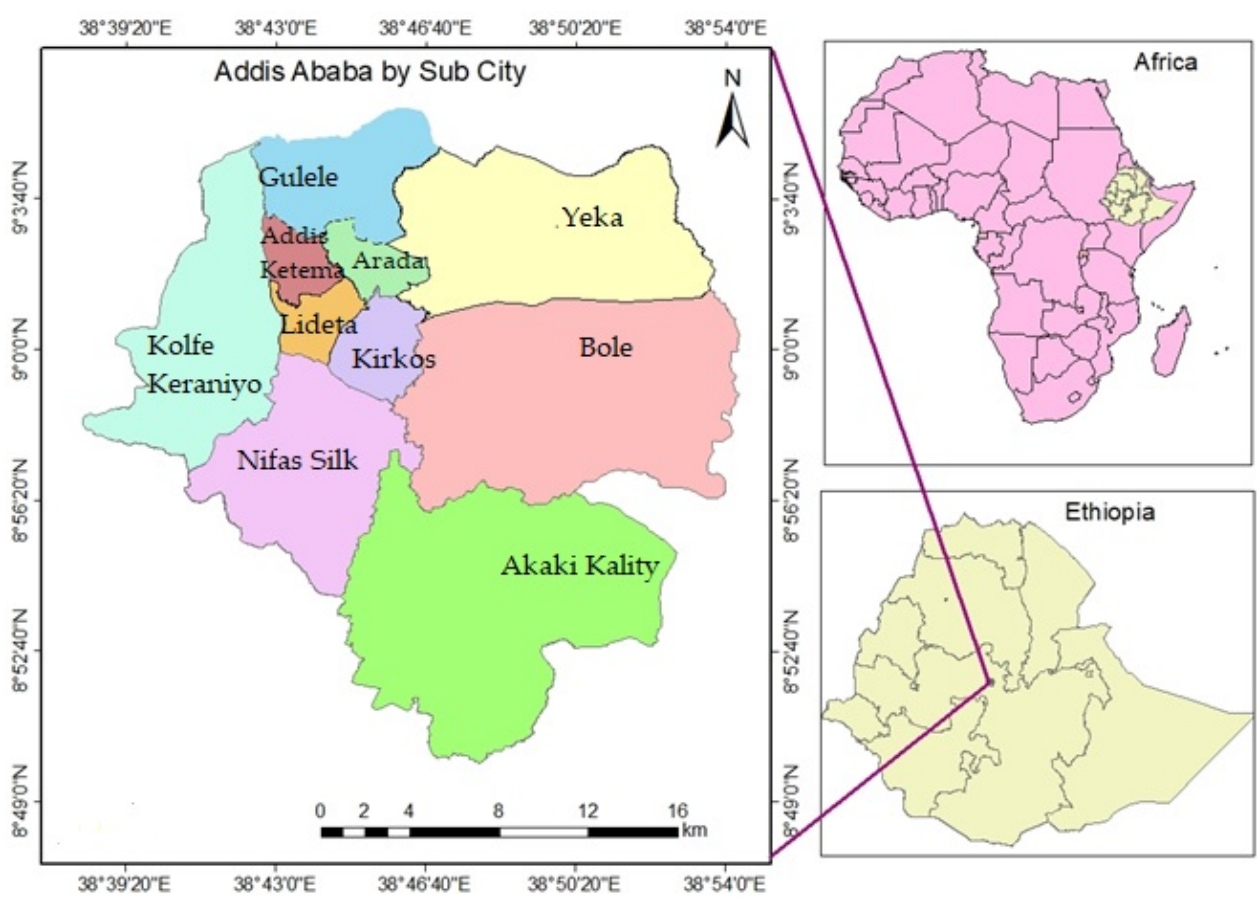
Figure 2. Location map of the study area (Author developed).